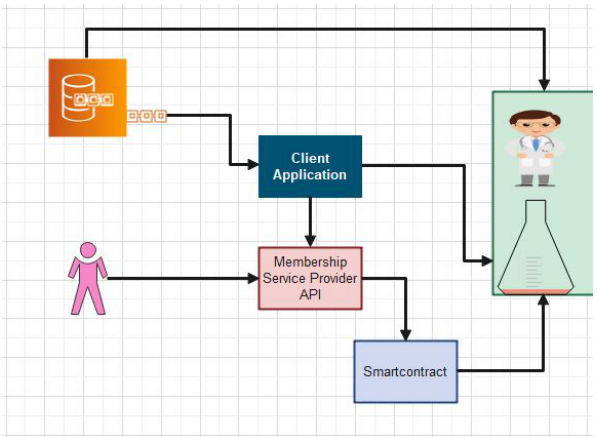
Figure 5. Transactions of Electronic Health Records through blockchain-based healthcare system.